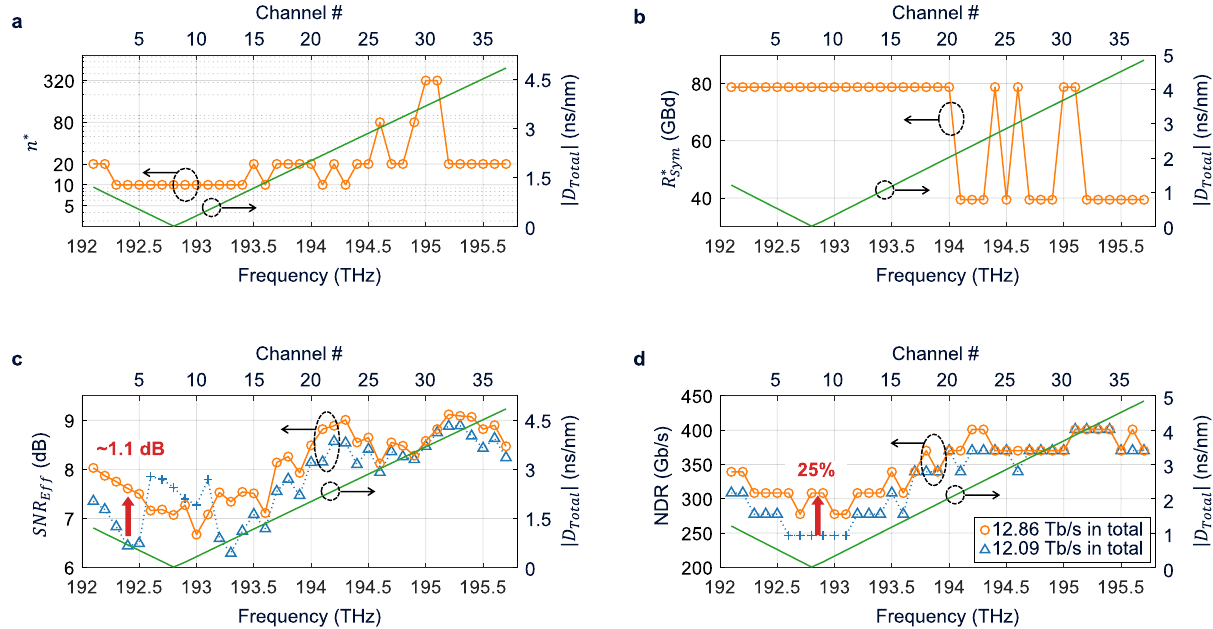
Fig. 5 Experimental results obtained with the nonlinear fi ber-channel-optimized sphere shaping. a Optimal shaping length n (cid:5) for maximum NDR that tends to increase with the total net dispersion D Total increases from approximately 2 to 4 ns/nm. c The effective SNR achieved by the fi ber-channel-optimized n (cid:5) and R (cid:5) Sym (orange circles) and by the linear- channel-optimized n ¼ 320 at R Sym ¼ 39 : 4GBd (blue triangles and pluses). d The NDRs achieved by the fi ber-channel- optimized and linear-channel- optimized sphere shaping con fi gurations. Near the zero-dispersion regime, an NDR increase of up to 25% is achieved by the fi ber-channel-optimized